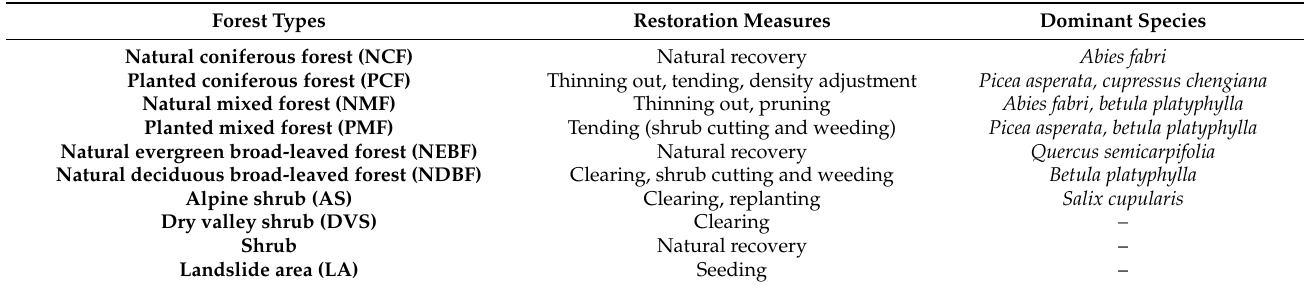
Table 2. The restoration measures for major forest types [28,29].